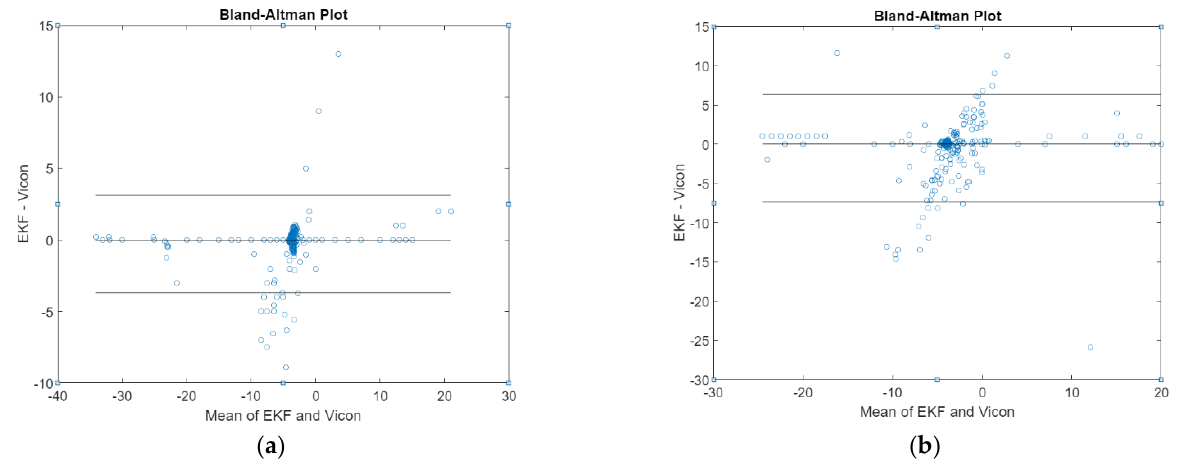
Figure 8. Bland–Altman plot of ( a ) pitch θ ( ⸰ ) angle, and ( b ) roll ϕ ( ⸰ ) angle derived from attitude EKF2.